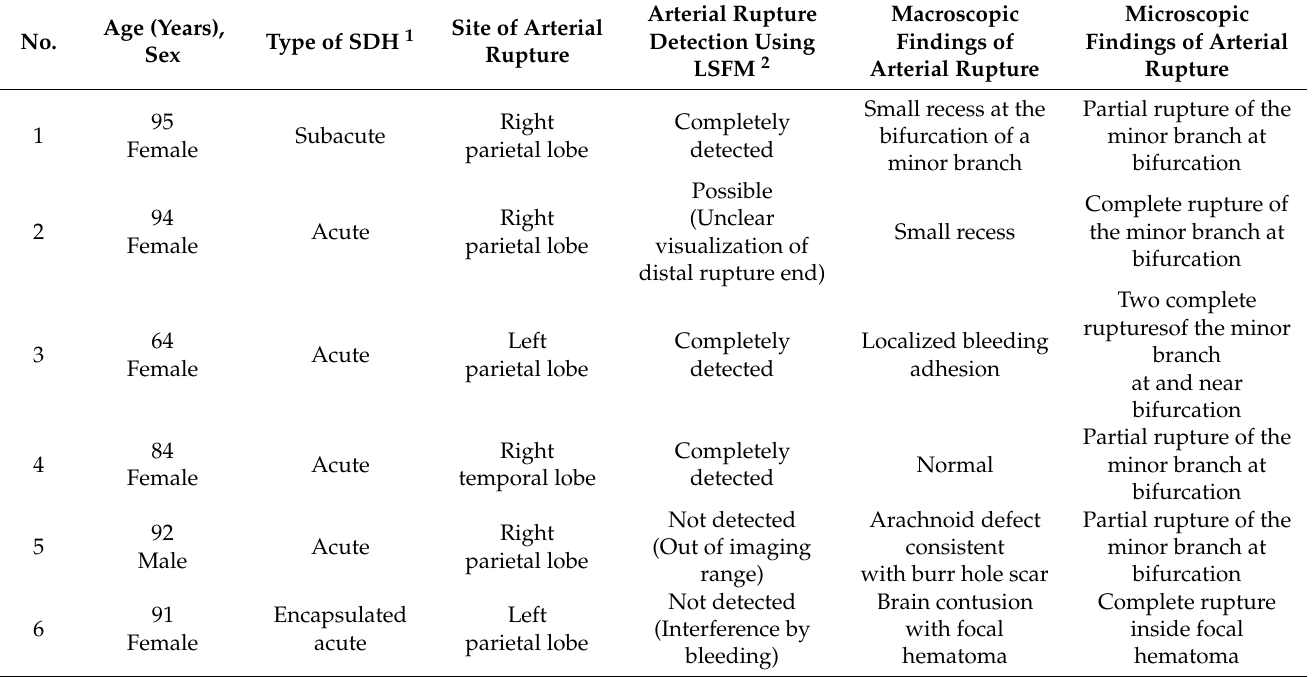
Table 1. Summary of the